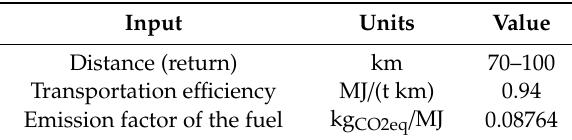
Table 3. Input data for cardoon